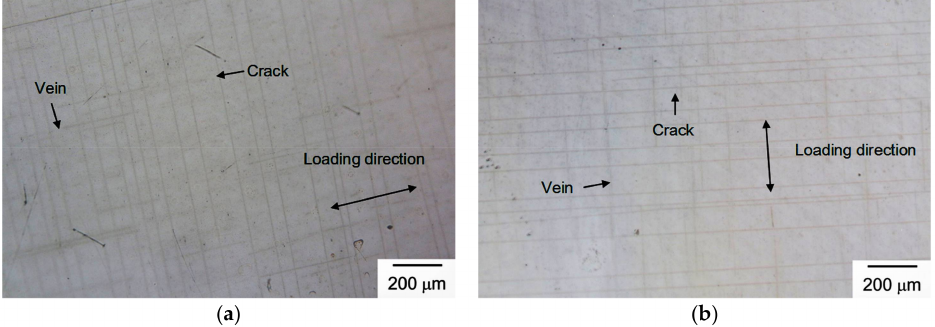
Figure 11. OM micrographs of barrier films after tensile bending with ( a ) a 10-mm and ( b ) a 5-mm curvature radius for 1000